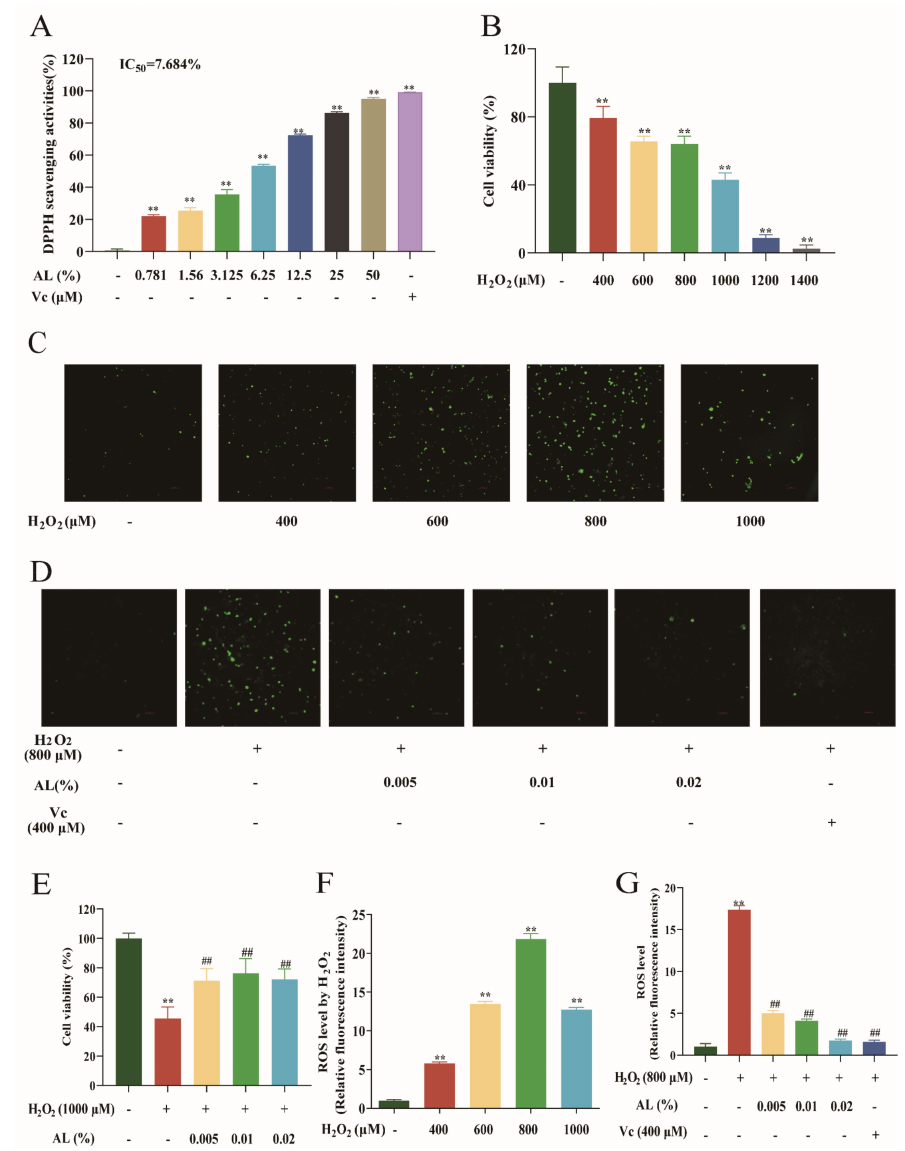
Figure 5. AL reduced H 2 O 2 -induced oxidative damage and ROS in HaCaT cells. ( A ) DPPH Scaveng- ing activities of AL in vitro. ( B ) Cell viability for 24 h after treatment with H 2 O 2 for 4 h in HaCaT cells. After 4 h treatment with different concentrations of H 2 O 2 ( C ), or after 24 h treatment with 0.005%, 0.01%, and 0.02% AL or 400 µ M Vc ( D ), the HaCaT cells were fluorescently labeled with a DCFH-DA probe, and a representative image of ROS was selected (10 × ). ( E ) Cell viability for 24 h after treatment with 0.005%, 0.01%, and 0.02%AL or 400 µ M Vc using a CCK8 assay. ( F ) Quantitative analysis of ROS images induced by H 2 O 2 for 4 h. ( G ) Quantitative analysis of ROS images induced by H 2 O 2 after treatment with 0.005%, 0.01% and 0.02% AL or 400 µ M Vc for 24 h. Results are expressed as means ± SDs of three independent experiments. ** p < 0.01compared to the normal group (no treatment); ## p < 0.01compared with the H 2 O 2 group. One − way ANOVA was used to evaluate